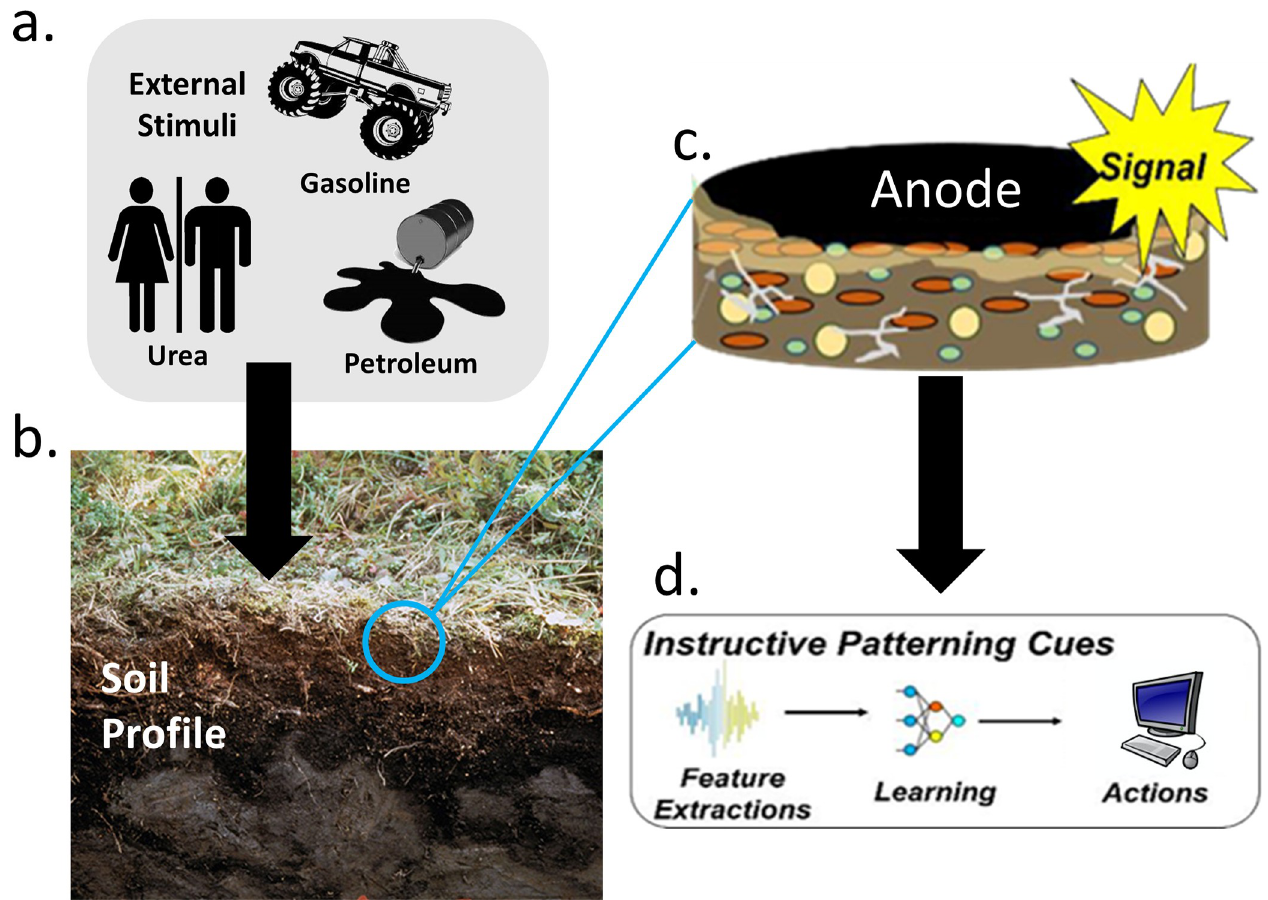
Fig 1. The additional external stimuli may solicit a repeatable response in electrogenic bacteria embedded on electrodes in soil.